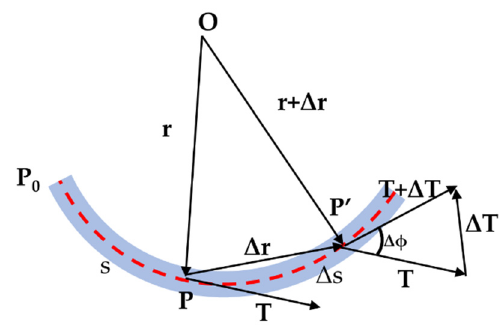
Figure 3. Differential geometry of a space curve.